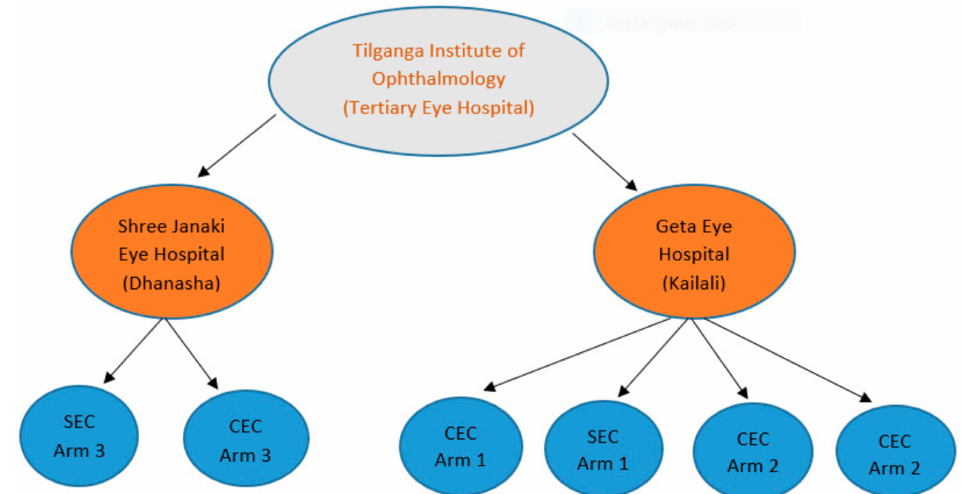
Figure 3. Pragmatic Trial Design. Tilganga Institute of Ophthalmology is a tertiary eye hospital and also a managing partner of the project. Shree Janaki Eye Hospital and Geta Eye Hospital are base, partner hospitals of the project situated in East and West part of Nepal. The trial included one Secondary Eye Centre (SEC) and one Community Eye Centre (CEC) under Shree Janaki Eye Hospital—control site. Geta Eye Hospital was the intervention site and included three Community Eye Centers and one Secondary Eye Centres. The CEC and SEC from both base hospitals are situated in plain and mountain part of